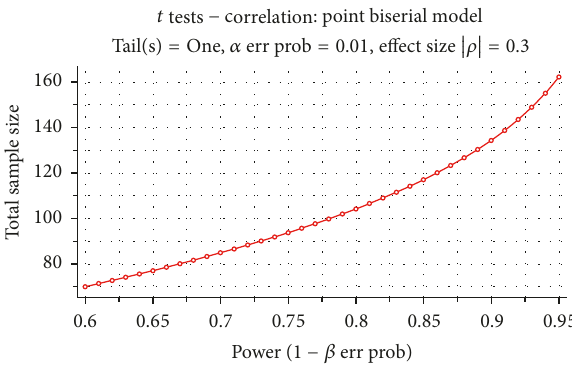
Figure 1: Sample size